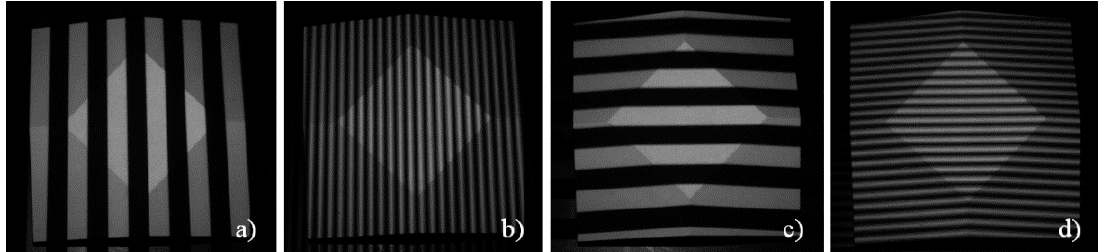
Figure 9. Selected images from fringe sequence: parts of Gray-code sequence ( a , c ) and sinusoidal fringes ( b , d ) taken from underwater measurements of a frustum of a pyramid.